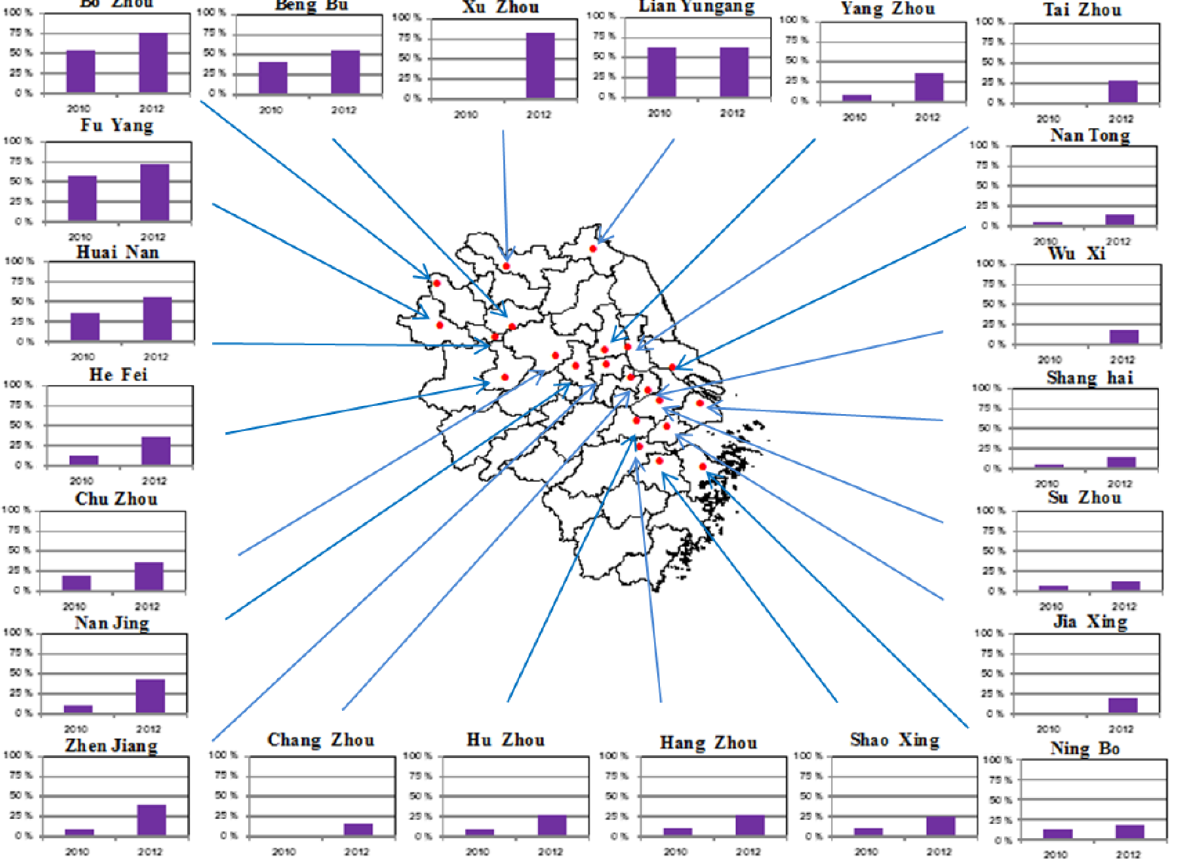
Figure 8. The contribution of OBB to PM 10 concentrations for different YRD cities during OBB events in June 2010 and